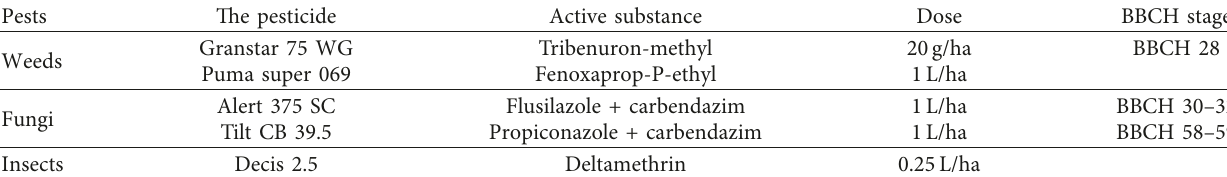
Table 6: Chemicals used in the protection of spring wheat against